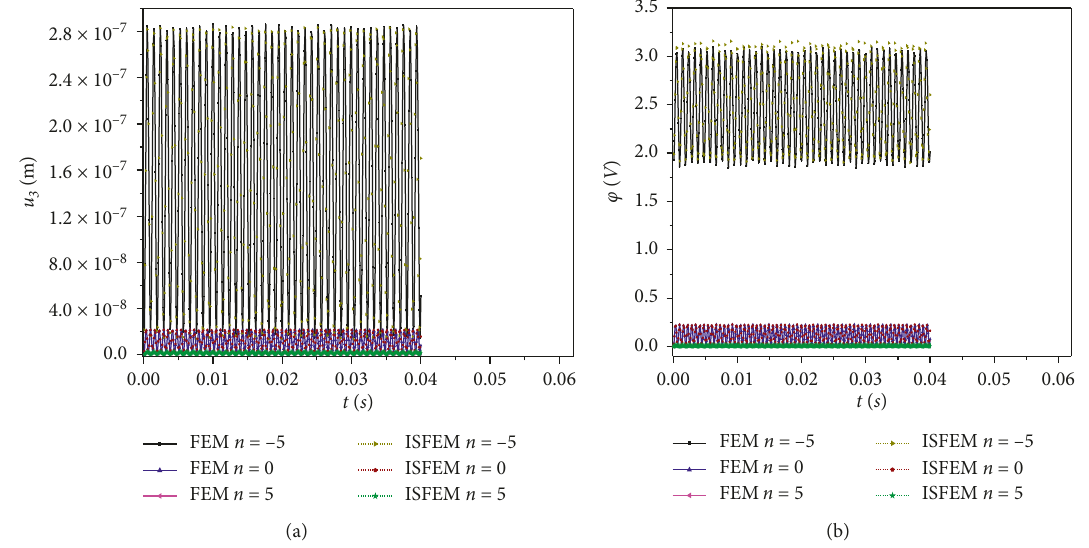
Figure 13: Variations of displacement u 3 and electrical potential φ at the loading point with time of the FGPM beam based on PZT-5H when the gradient parameter was n � − 5, 0 and 5 under step load. (a) Displacement. (b) Electrical